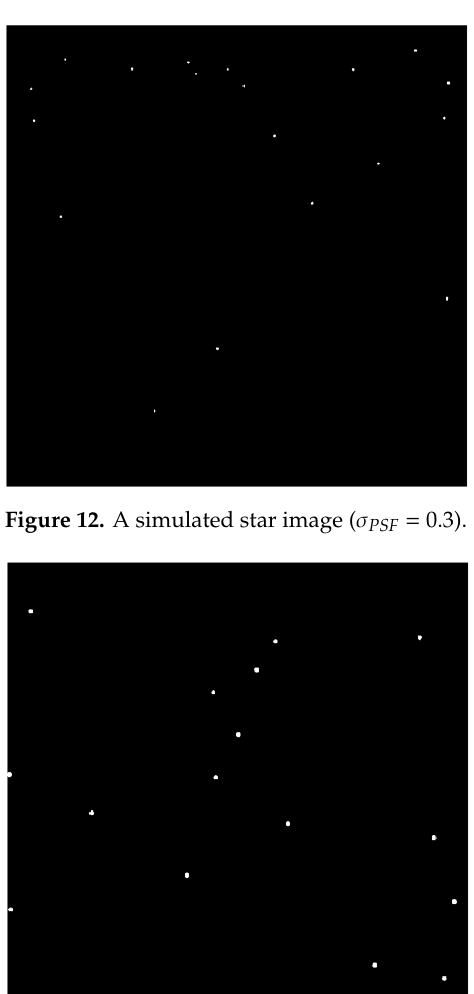
Figure 13. The simulated star image ( σ PSF =